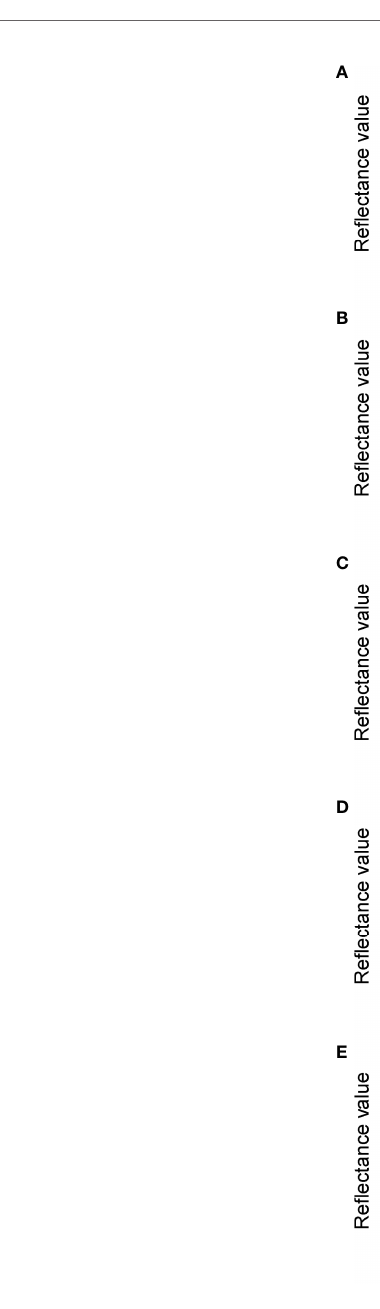
FIGURE 5 | Selected wavebands of different IR for detecting DSP toxins. (A) IR=100:100, (B) IR=100:80, (C) IR=100:60, (D) IR=100:40, (E)